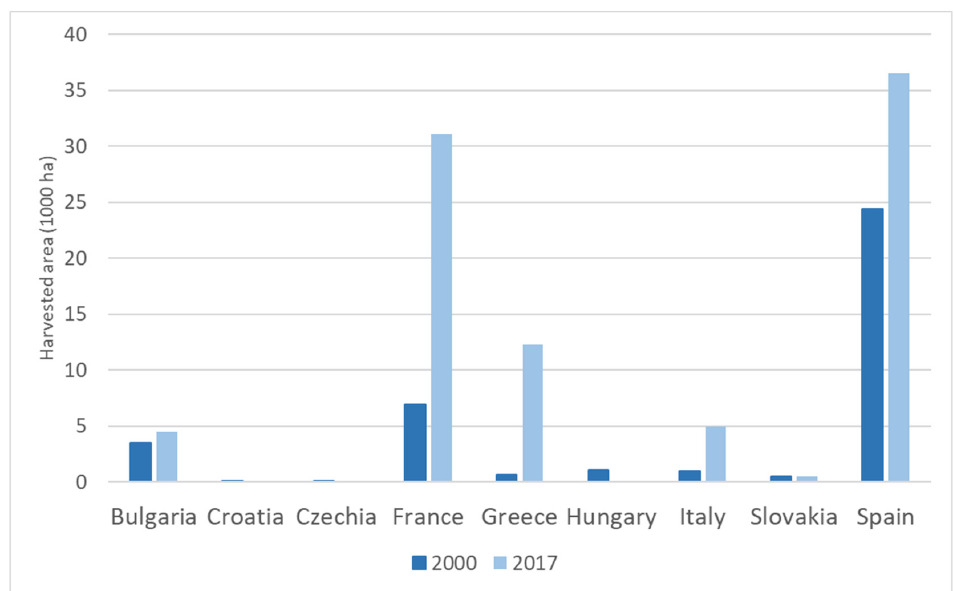
Figure 18. Harvested area of lentil in EU countries in 2000 and in 2017 [35].